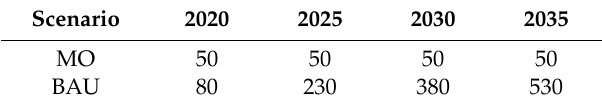
Table 3. The carbon price under the MO and BAU carbon policy scenarios